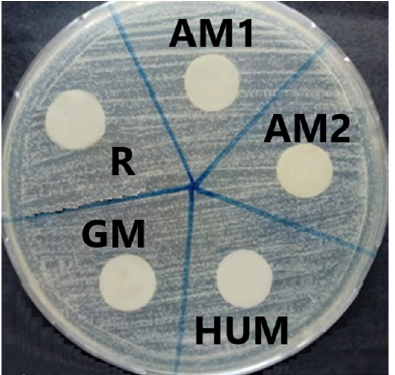
Figure 9. Contact of experimental PMMA bone cements towards Candida albicans ATCC 10231.